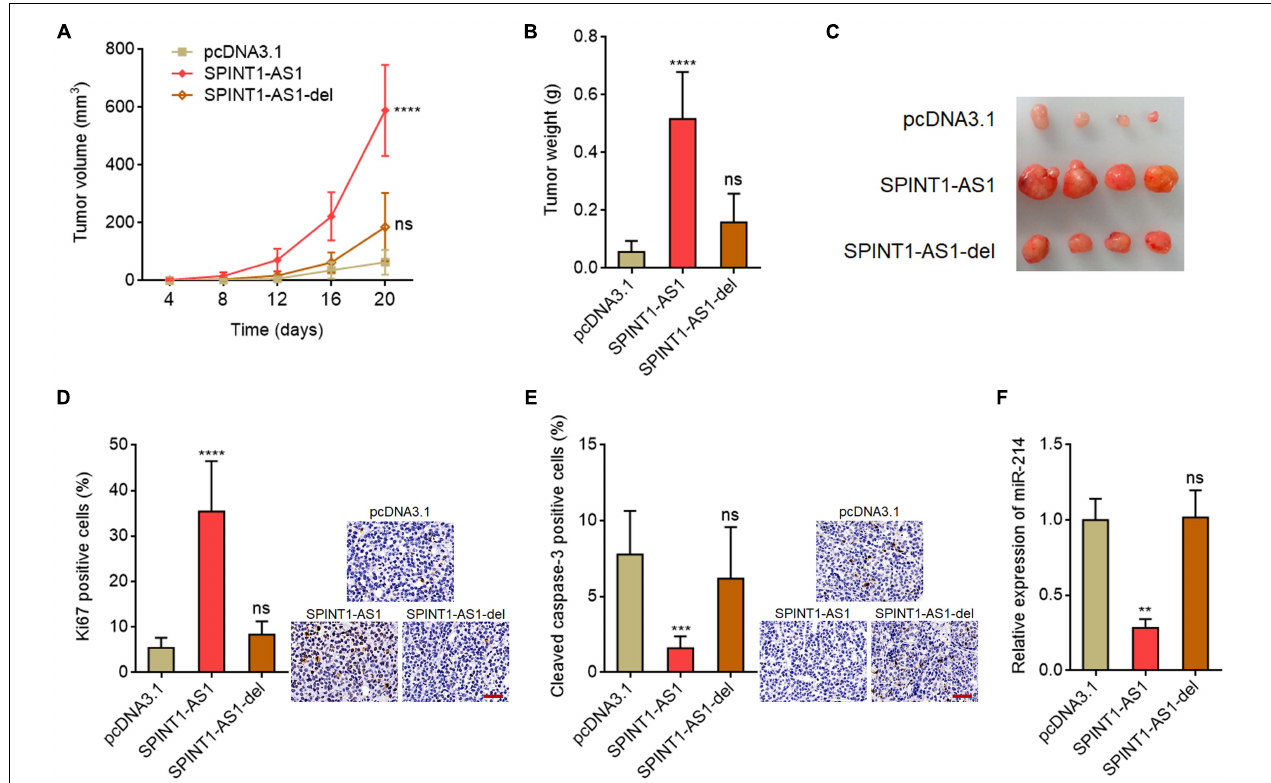
FIGURE 5 | SPINT1-AS1 drove cervical cancer tumorigenesis in vivo in a miR-214 dependent manner. (A) HeLa cells with SPINT1-AS1 or 5 (cid:48) 70 nucleotides deleted SPINT1-AS1 (SPINT1-AS1-del) stable overexpression were subcutaneously inoculated into nude mice. Tumor volumes were detected every 4 days. (B) Subcutaneous tumors were excised and weighed at the 20th day after inoculation. (C) Representative photo of subcutaneous tumors excised at the 20th day after inoculation. (D) Ki67 IHC staining was performed using the excised subcutaneous tumors. Scale bars, 50 µ m. (E) Cleaved caspase-3 IHC staining was performed using the excised subcutaneous tumors. Scale bars, 50 µ m. (F) miR-214 expressions in the excised subcutaneous tumors was detected by qRT-PCR. Results are shown as mean ± SD based on n = 7 mice in each group. ** P < 0.01, *** P < 0.001, **** P < 0.0001, ns, not significant, by one-way ANOVA followed by Dunnett’s multiple comparisons